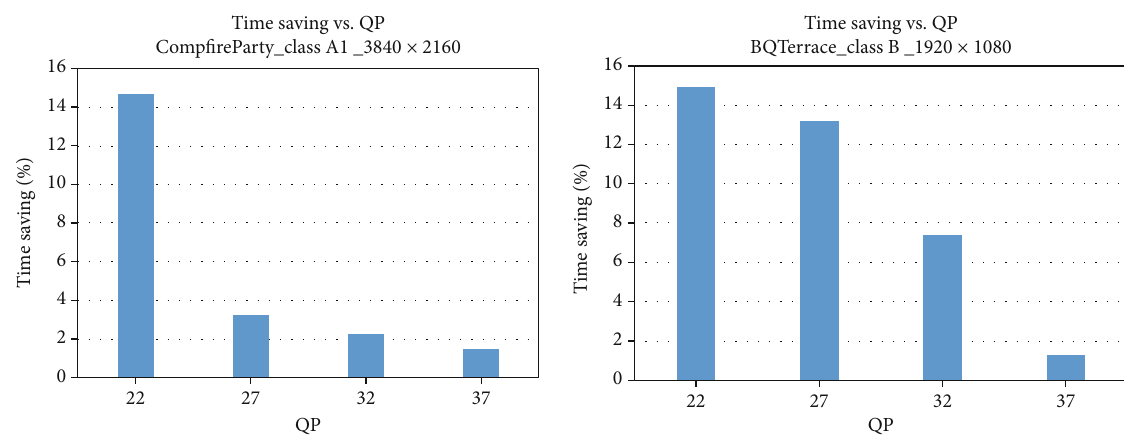
Figure 13: Time saving curves for sequences encoded with QP37, 32, 27, and 22 in